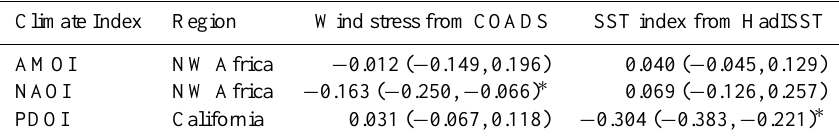
Table 2. Pearson’s correlation coefficients for the basin-scale oscillations AMO, NAO with the upwelling indices off NW Africa and PDO with upwelling index off California. Values in parentheses denote the 95%-bootstrap confidence intervals for the correlation coefficient. A ∗ indicates that the correlation is statistically significant at the 0.05